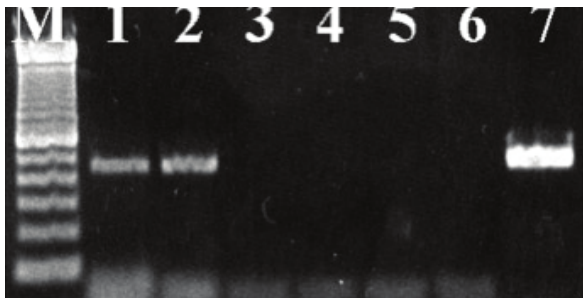
Figure 1. Amplification by nested polymerase chain reaction of BoHV-1 in supernatant of MDBK cells co-cultured with oocytes pre-cultured with uterine epithelial cells pre-inoculated with BoHV-1 (Experiment 2). M: weight molecular markers; 1: